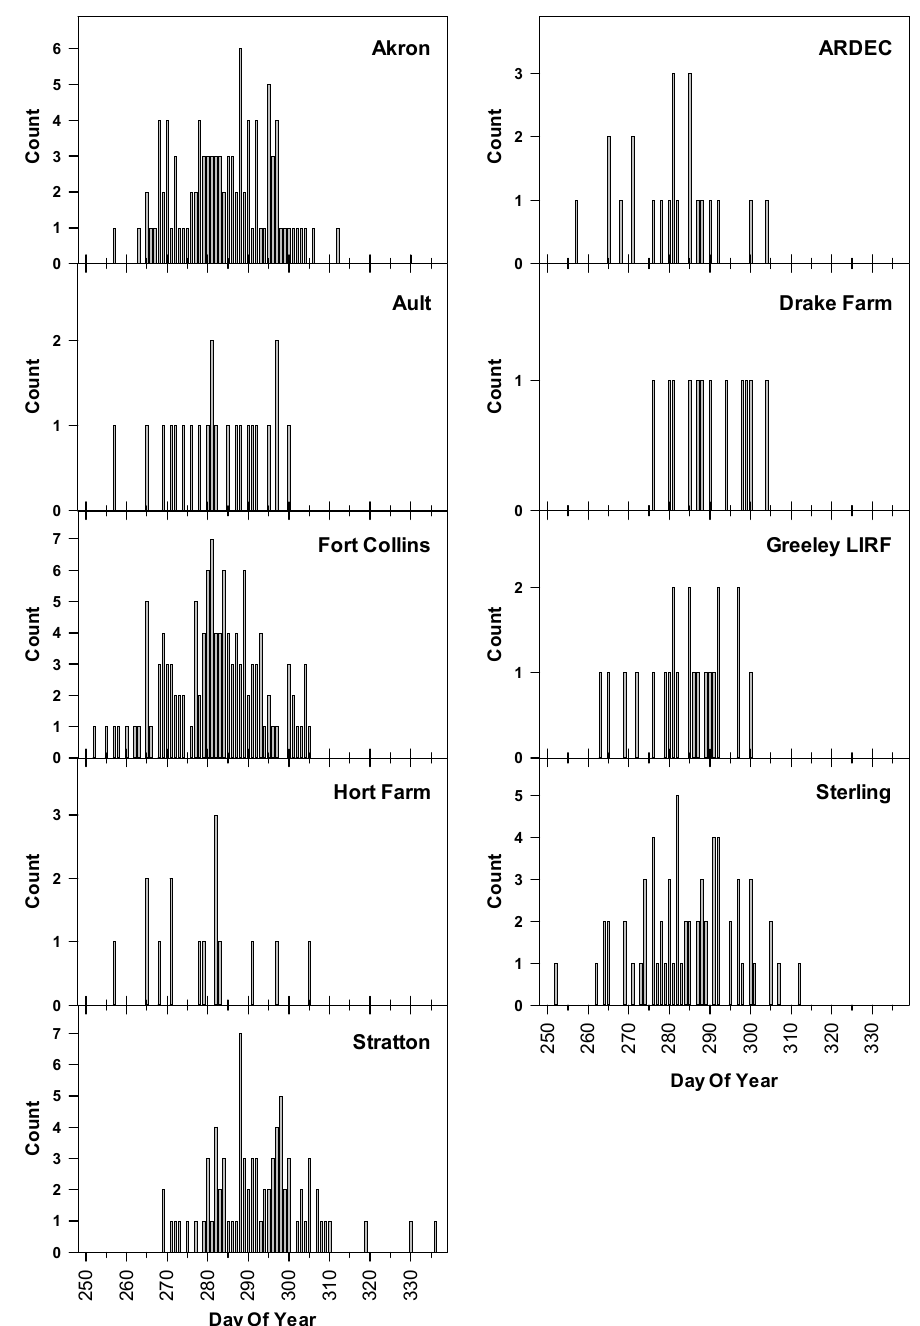
Figure 1. Frequency distribution of first frost date in a year for nine locations.